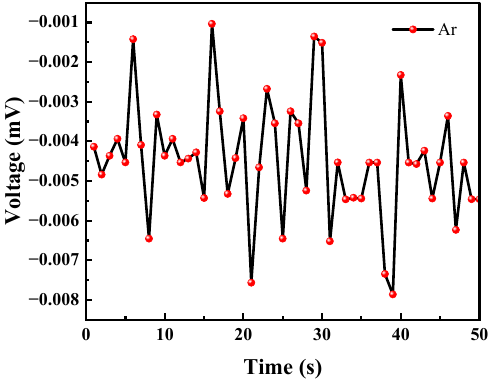
Figure 17. Argon causes voltage changes.